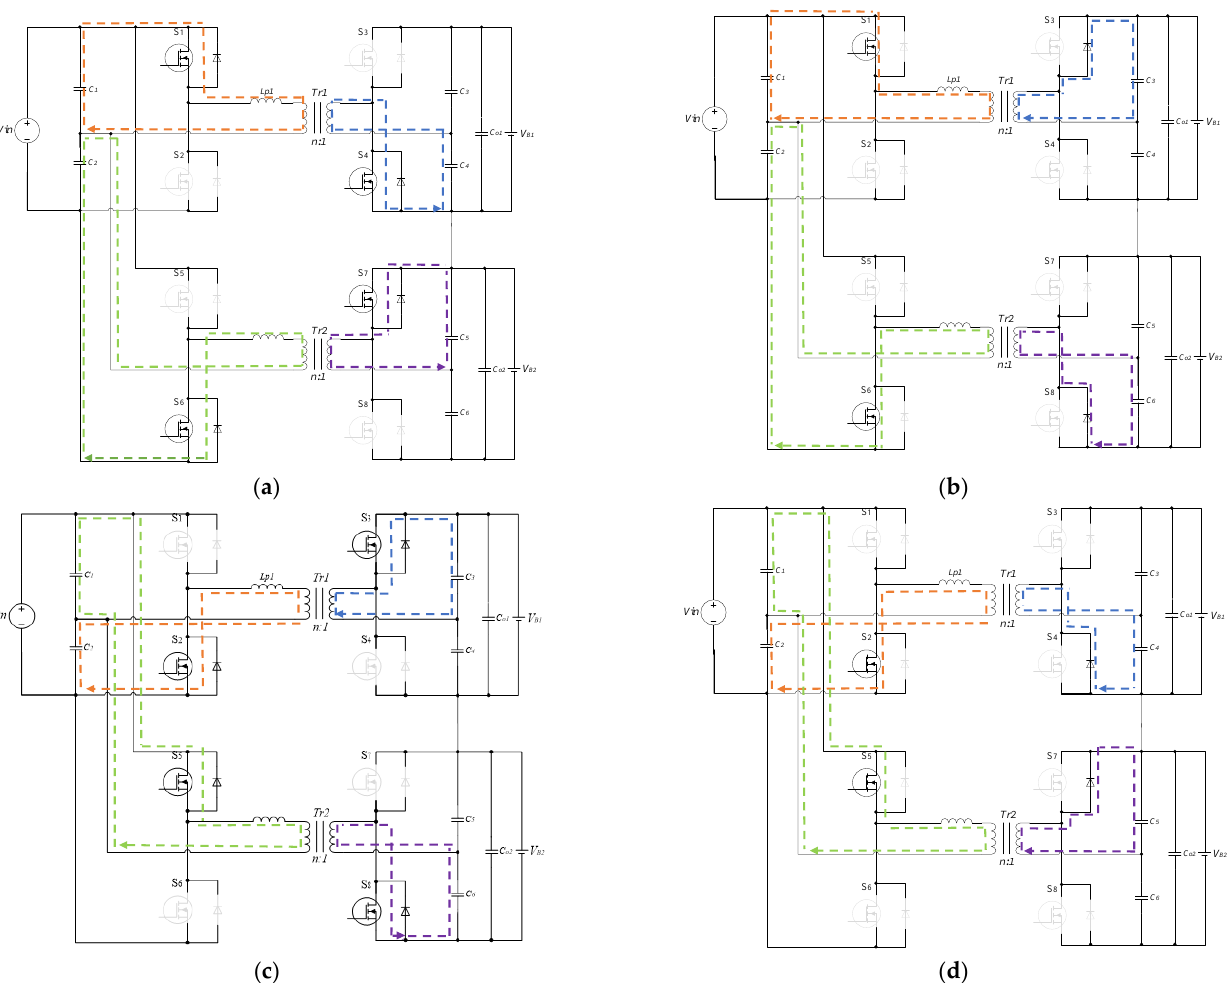
Figure 4. Key waveforms of the HBDAB converter.